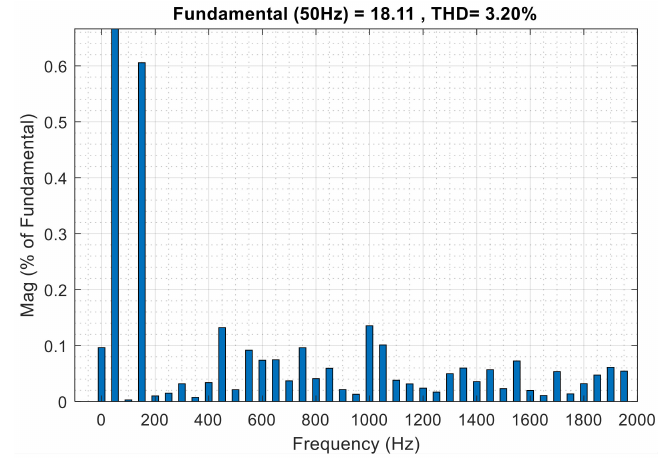
Figure 13. Harmonic spectrum of the output current of ZSI 1, i 1